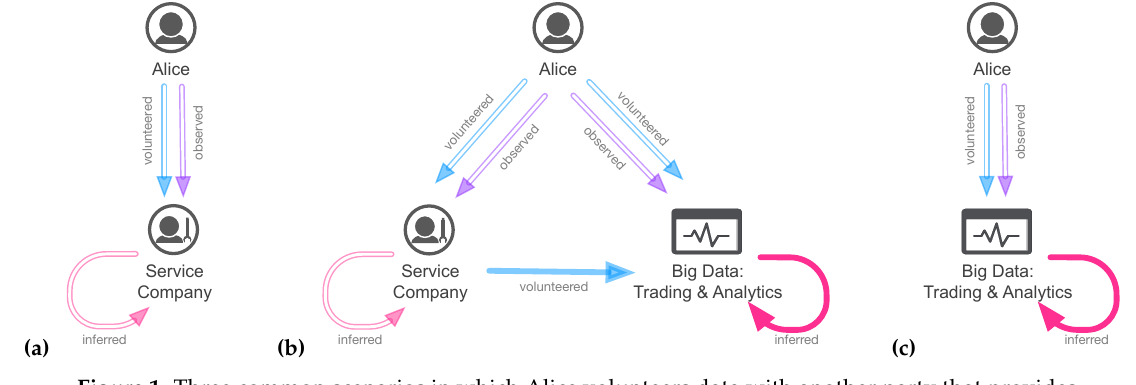
Figure 1. Three common scenarios in which Alice volunteers data with another party that provides some service: ( a ) An isolated service provision. ( b ) A service provision with ‘unknown friend benefits’. ( c ) A ‘full monty’ service